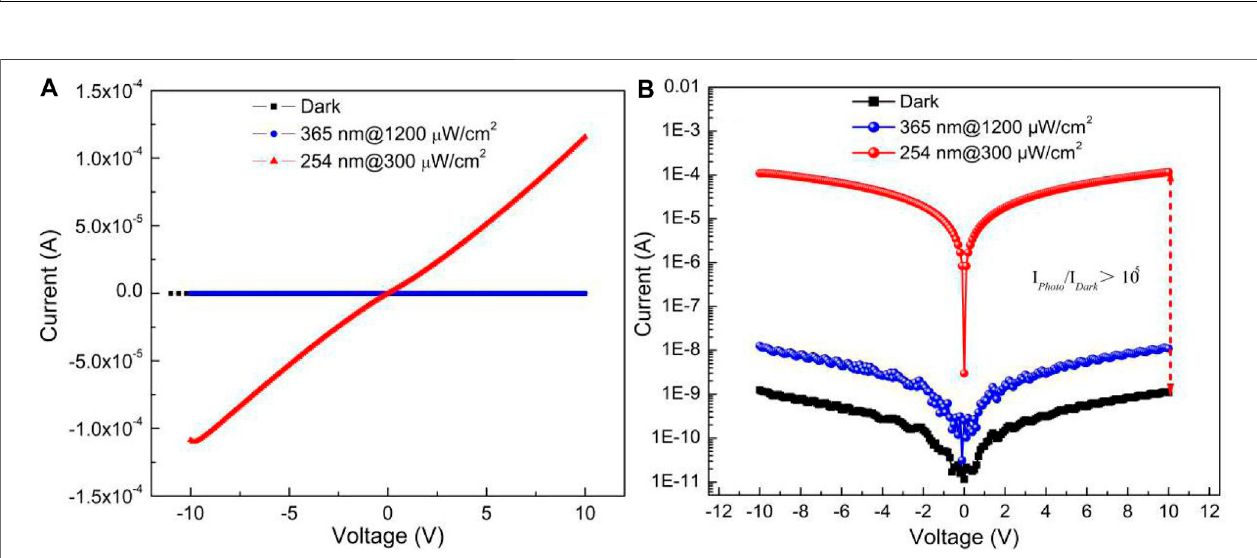
FIGURE3| (Coloronline)I – Vcharacteristiccurvesofthe β -Ga 2 O 3 PDin (A) linearand (B) logarithmiccoordinatesunderdarkconditionsand365and 254-nmlight illumination, respectively.